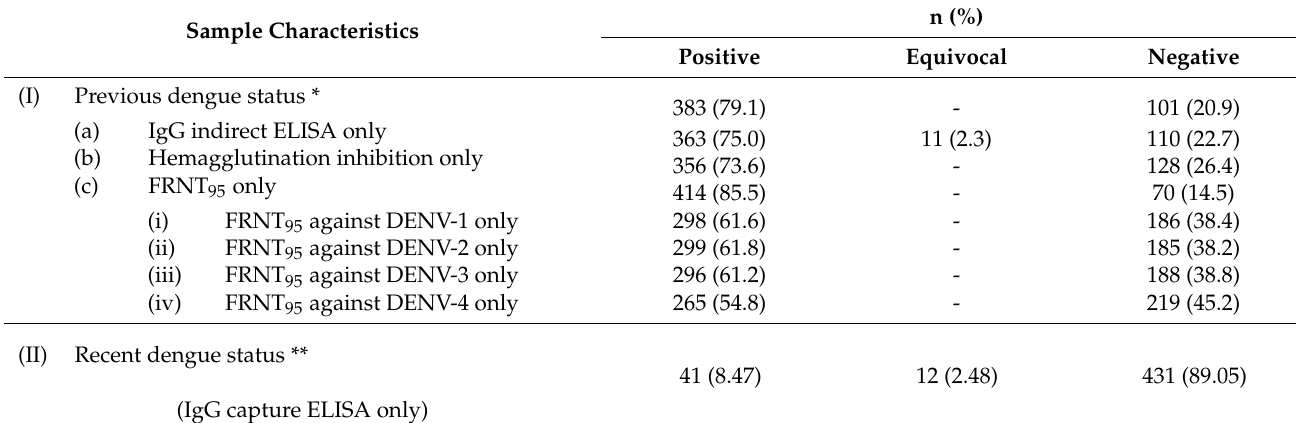
Table 1. Characterization of the 484 study participants.